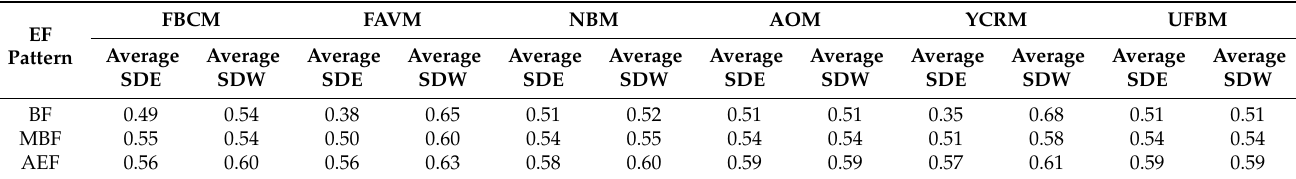
Table 4. Average SDE and SDW obtained by the six conflict-resolution methods according to different GCMs and EF